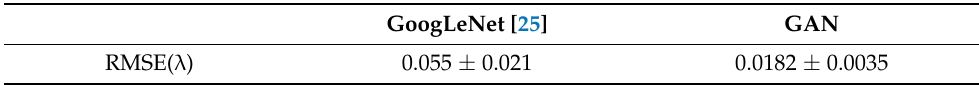
Table 3. The time consumption of two